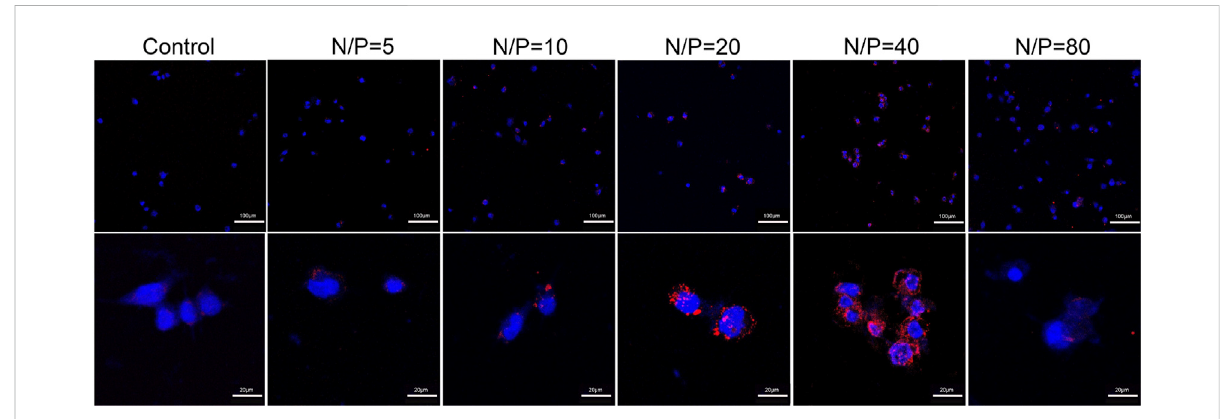
FIGURE 6 Fluorescent images of miR-29b-Cy3/GO-PEG-PEI complex with different N/P ratios (0, 5, 10, 20, 40, and 80) after 3 h of incubation. miR-29b was labeled using Cy3 (orange-red), and the cell nuclei were stained with DAPI (blue). Scale bars of upper images were 100 μ m, scale bars of lower images were 20 μ